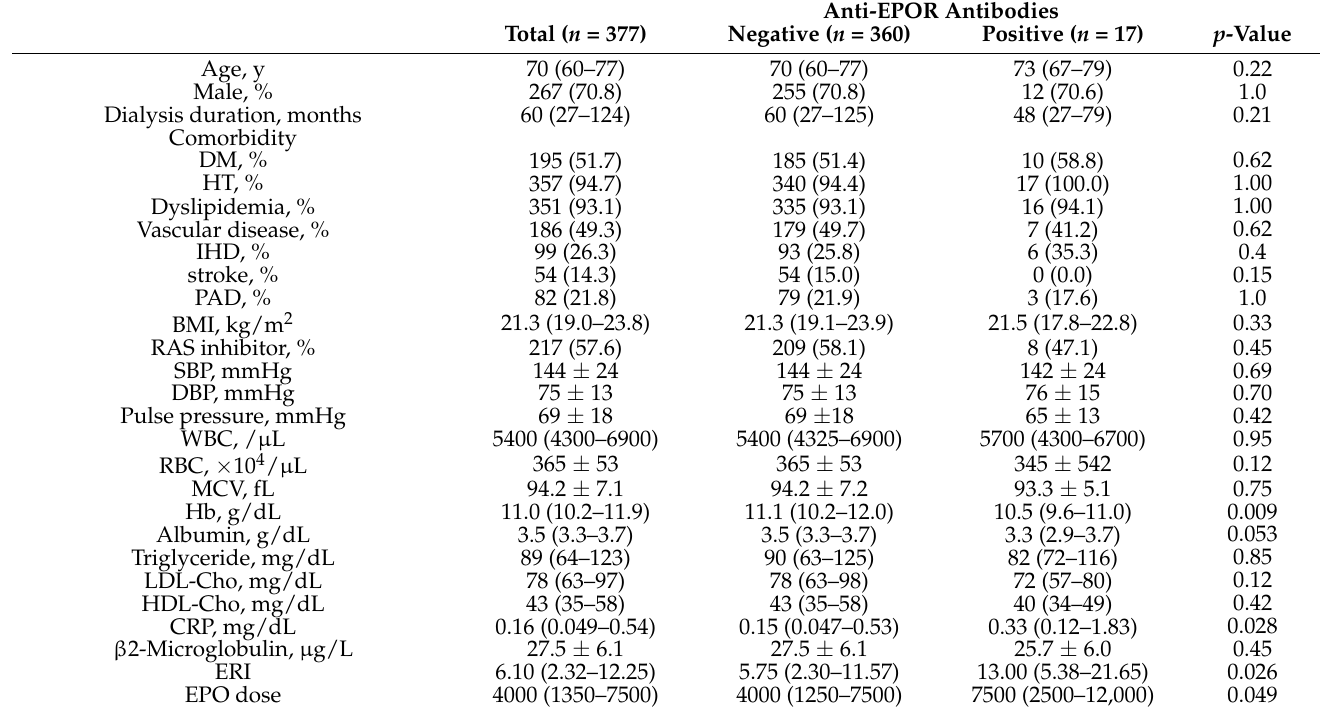
DM, diabetes mellitus; HT, hypertension; IHD, ischemic heart disease; PAD, peripheral artery disease; BMI, body mass index; DW, dry weight; RAS, renin–angiotensin system; SBP, systolic blood pressure; DBP, diastolic blood pressure; WBC, white blood cells; Hb, hemoglobin; -Cho, cholesterol; HDL, high-density lipoprotein; LDL, low-density lipoprotein; CRP, C-reactive protein; ERI, erythropoietin resistance index; EPO dose, erythropoietin dose calculated by converting weekly epoetin- α